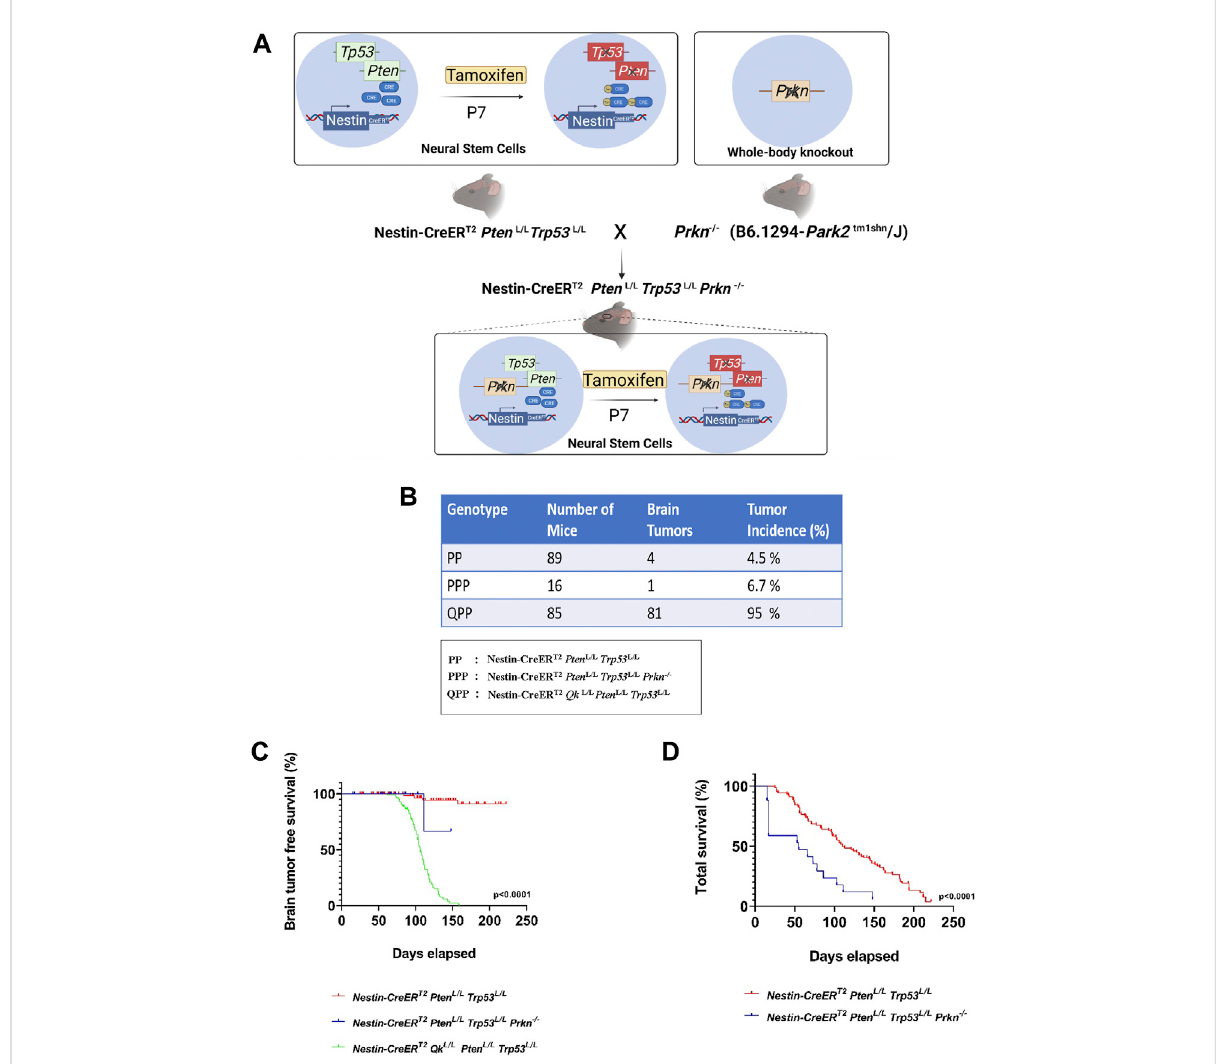
FIGURE 1 Prkn deletion does not lead to GBM development on the backdrop of Pten and Trp53 double knockout. (A) . Schematic describing the generation of the PPP genetic model. The illustrations were made using BioRender. (B) . The cohort sizes and brain tumor incidences tabulated for PPP, QPP, and PP models. (C) . Kaplan-Meier survival curves (long rank test) for PPP, QPP, and PP mice treated with tamoxifen (at P7-P10) demonstrating a signi fi cantly ( p < 0.0001) reduced brain tumor free survival rate for QPP and not for the PP and PPP. (D) . Kaplan-Meier survival curves(longranktest)forPPP,andPPmicetreatedwithtamoxifen(atP7-P8)demonstratingasigni fi cantly( p < 0.0001)reducedtotalsurvivalratefor the PPP mice compared to the PP